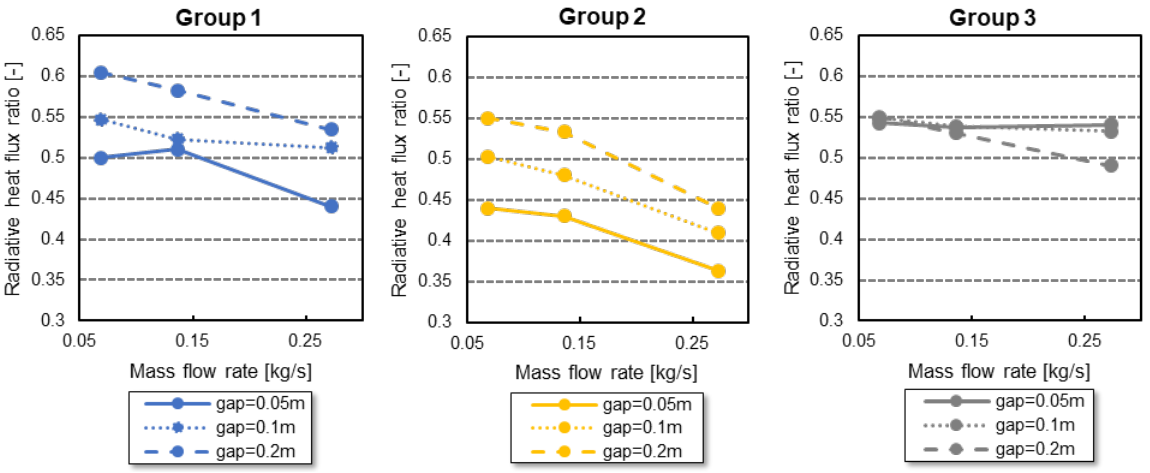
Figure 15. Evolution of radiative heat flux ratio with inlet mass flow rate for different system gap distances (Configuration 2).